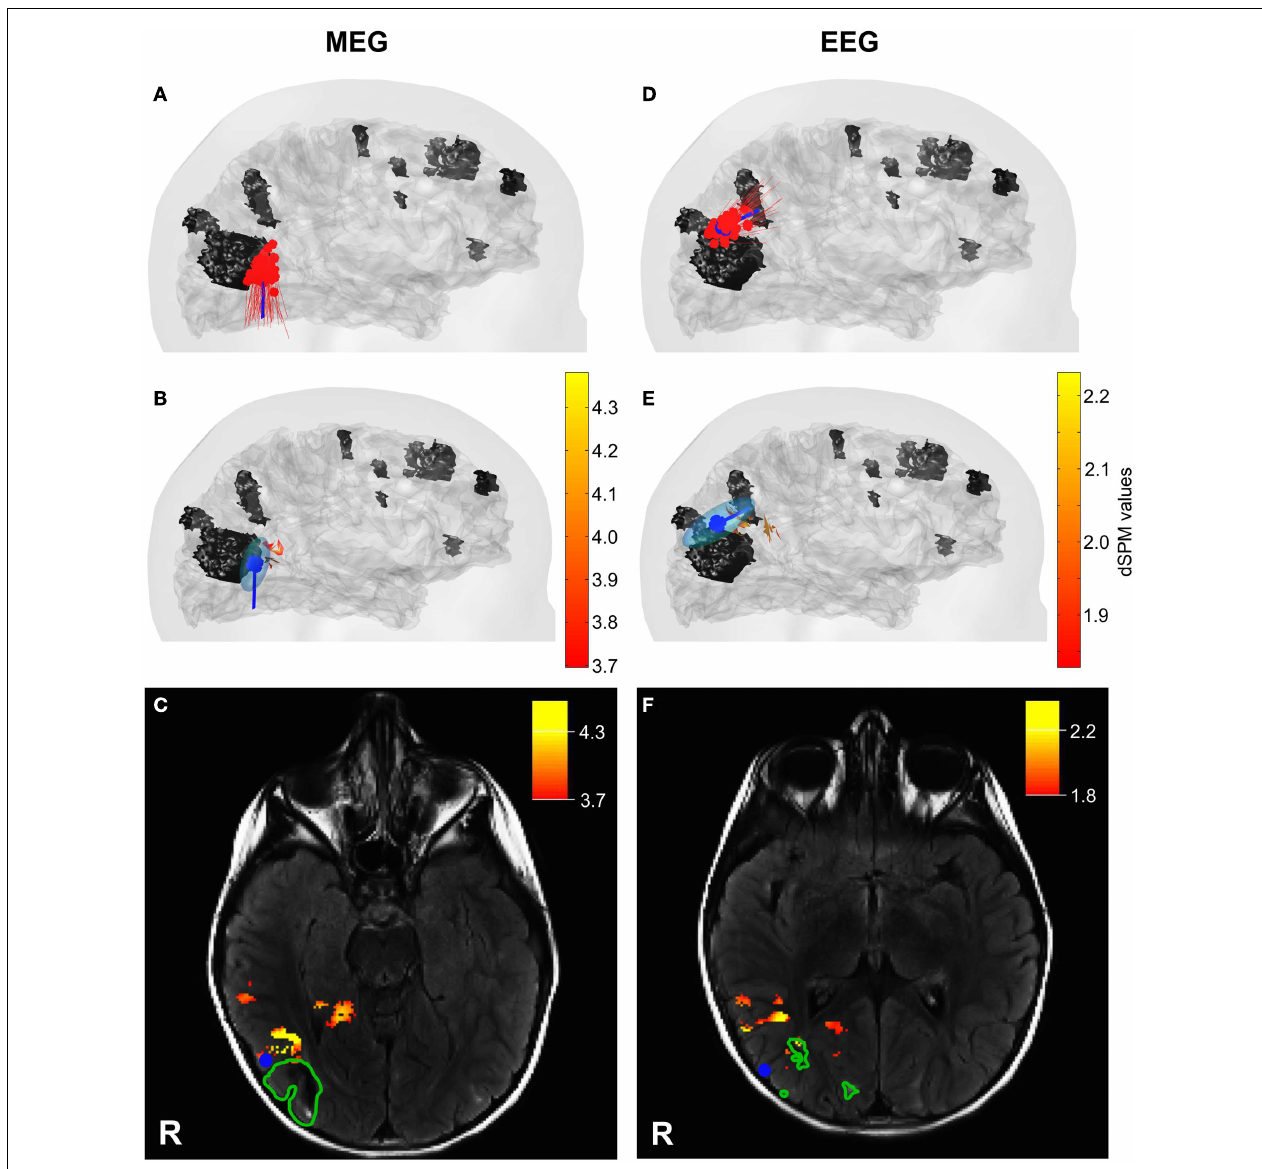
(blue) with ellipsoid representing the dipole-clusters.The tuber volumes are indicated in black. Skin and cortical surface are indicated in gray. (C,F) Axial slices of MRI FLAIR images with tuber margins (green), ECD localizations for averaged interictal spike (blue dot), and MNE localizations (red – yellow scale). R: